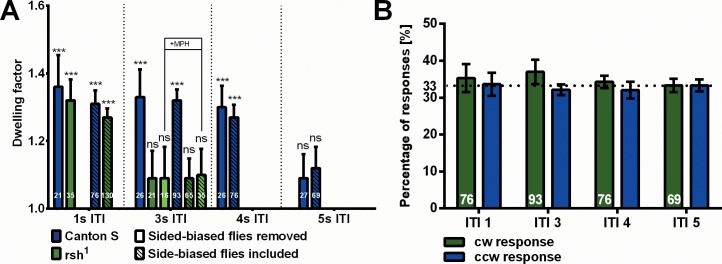
Temporal limitation of dwelling.(A) When the ITI is prolonged, the estimated dwelling factor does not decrease significantly in CantonS flies during the first 4s. However, the attention span lasts less than 5s. In the mutant rsh1 flies show wild-type like dwelling for an ITI of 1s, but the attention span lasts less than 3s. The same results are obtained, if the selection procedure (see Methods) for unbiased flies is not applied to the data. (B) For all four sets of CantonS experiments (ITI: 1, 3, 4 and 5s) the response polarity distribution is balanced for left and right responses. In all sets flies flew robustly and produced comparable patterns of responses. It is thus unlikely that differences in the behaviour of different batches of flies cause the observed differences.